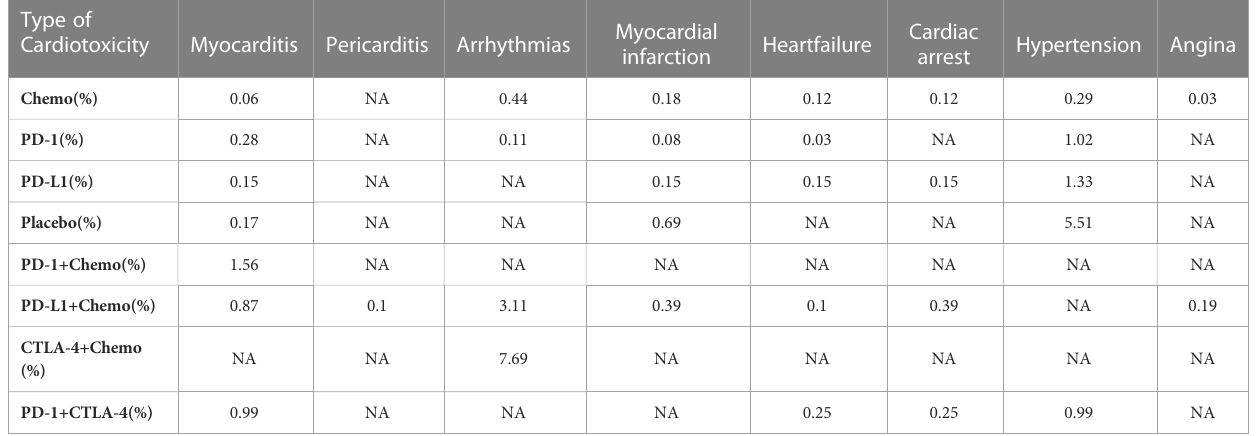
TABLE 3 The incidence of cardiotoxicity toxicity in different treatment groups.